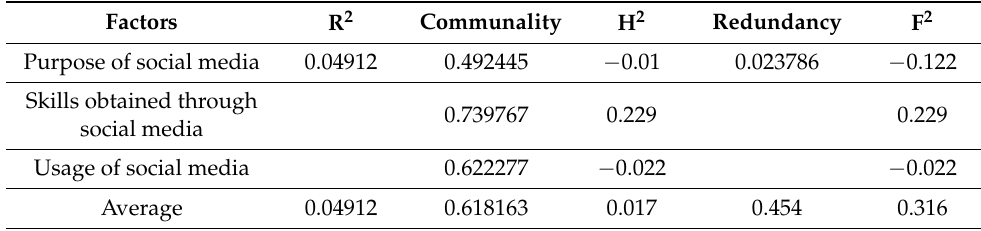
Table 7. Model evaluation results.